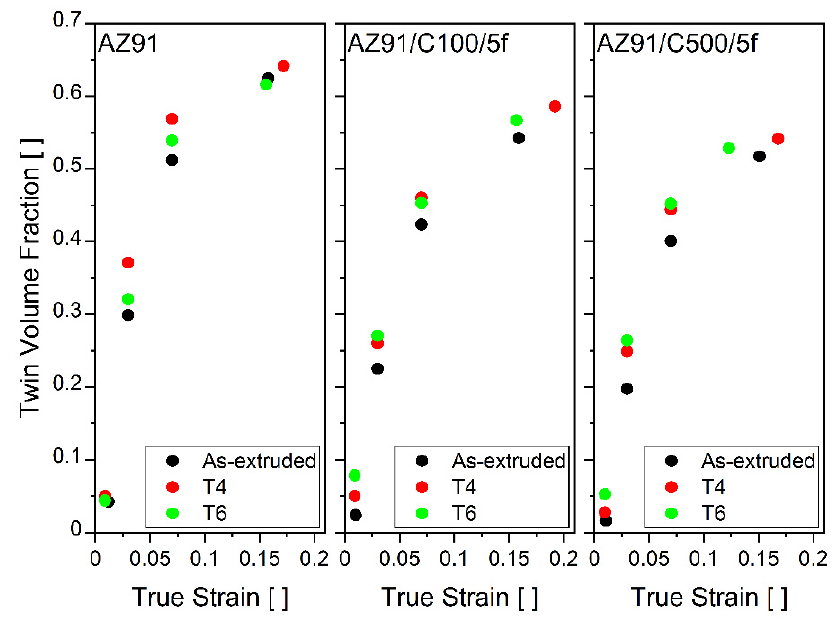
Figure 9. TVF of matrix against true strain for AZ91 ( left ), AZ91/C100/5f ( centre ), and AZ91/C500/5f ( right